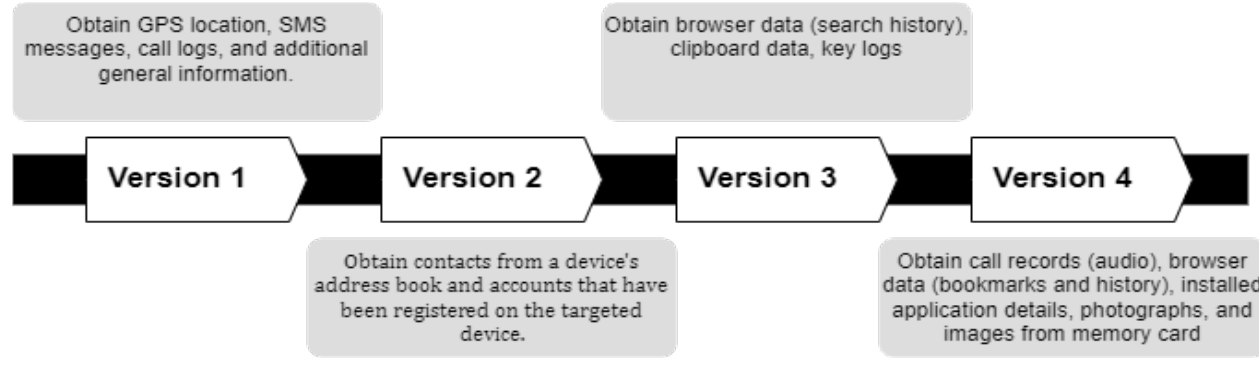
Figure 10. ZooPark attack versions.